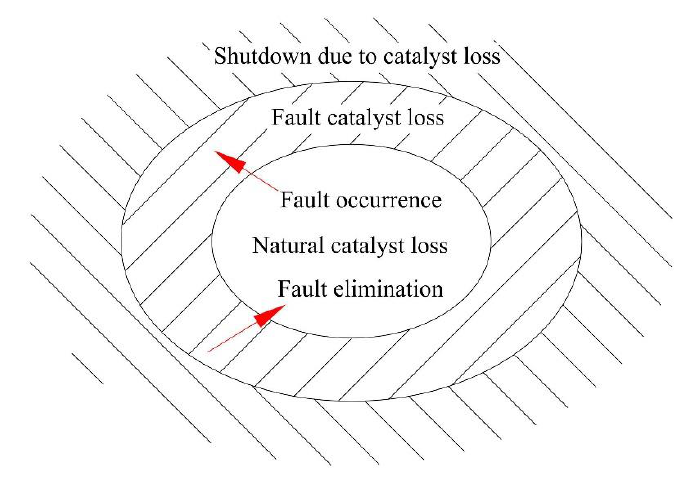
Figure 4. Classification of catalyst loss fault.